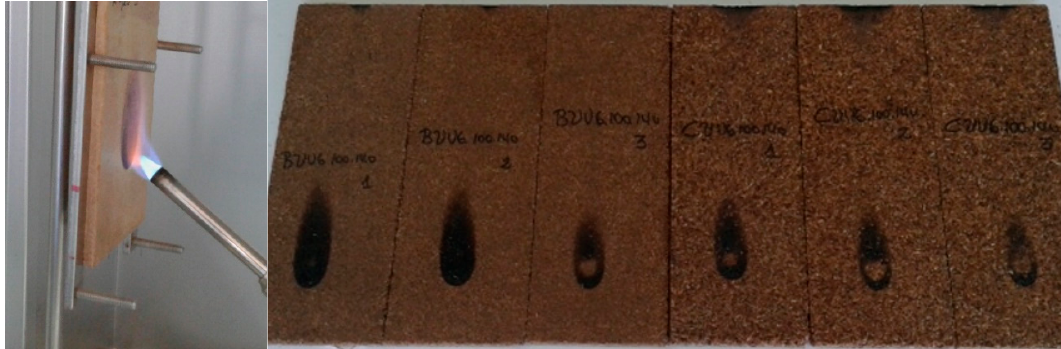
Figure 2. Sample placed on the frame and samples used in the reaction-to-fire test.